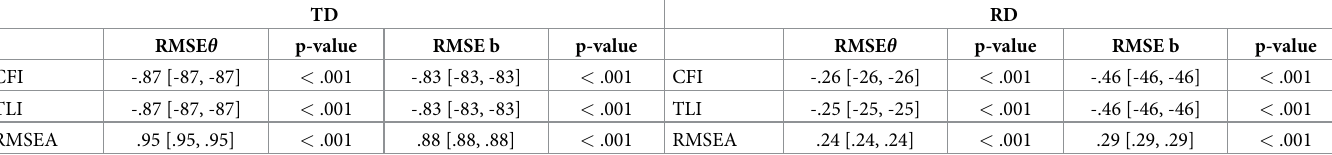
Note . Values in square brackets indicate the 95% confidence interval for each